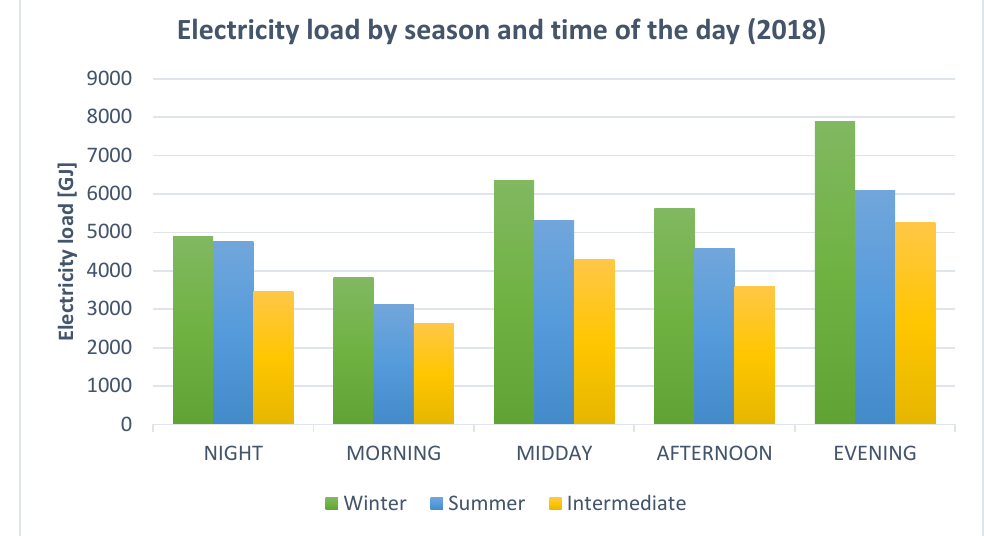
Figure 3. Procida ’ s electricity consumption share by sector in 2018.